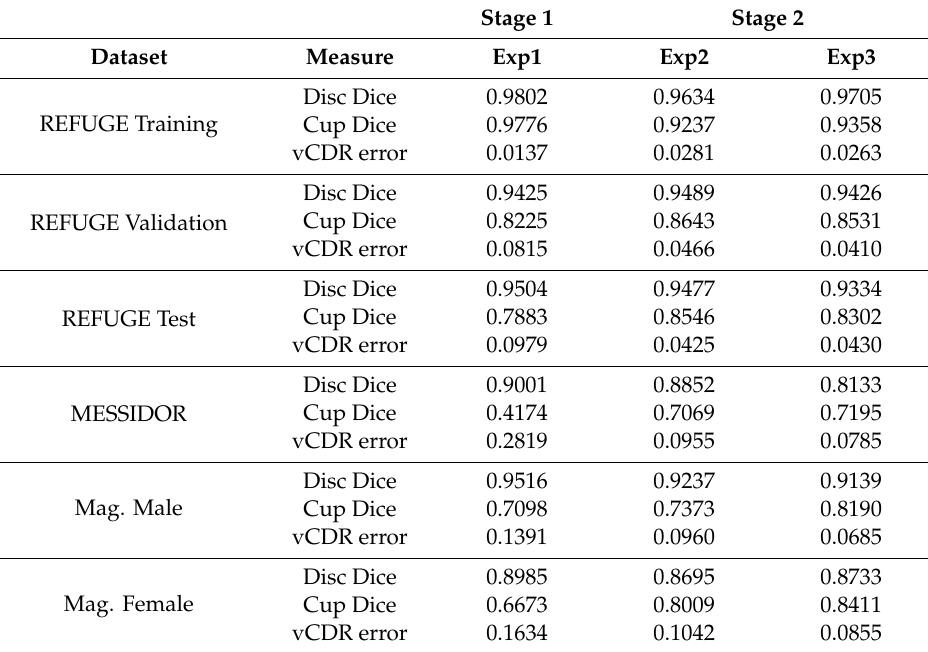
Table 2. Segmentation accuracy